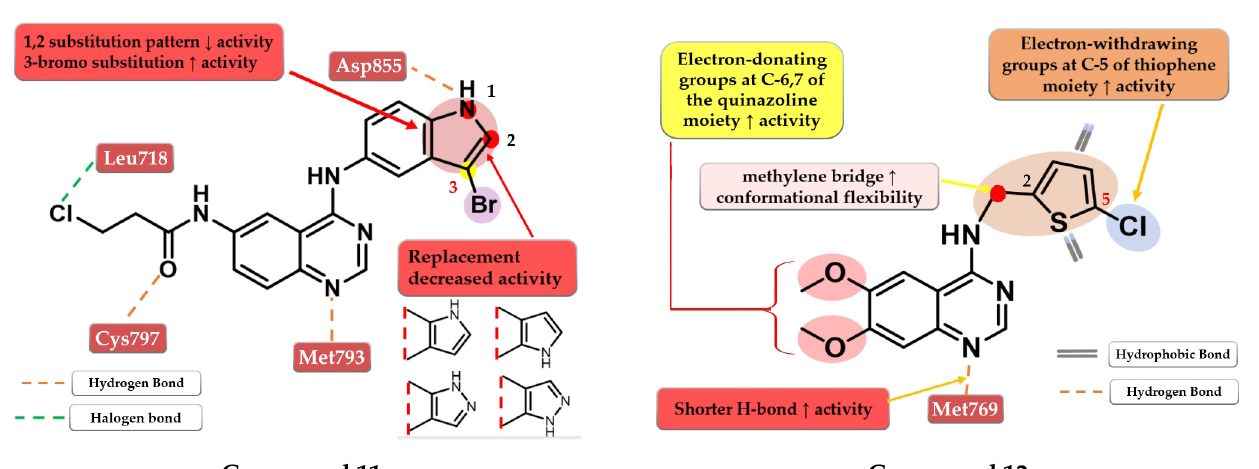
similar to the reference drug afatinib (Table S1) [116].